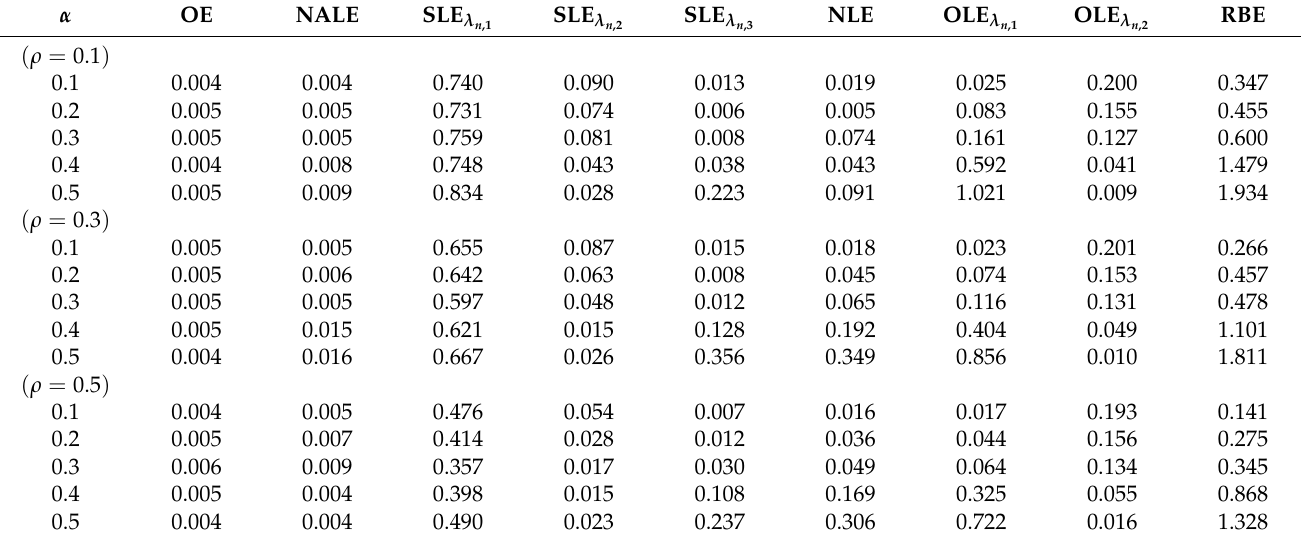
Table 3. Average MSE of various estimators, true σ 2 = 1.